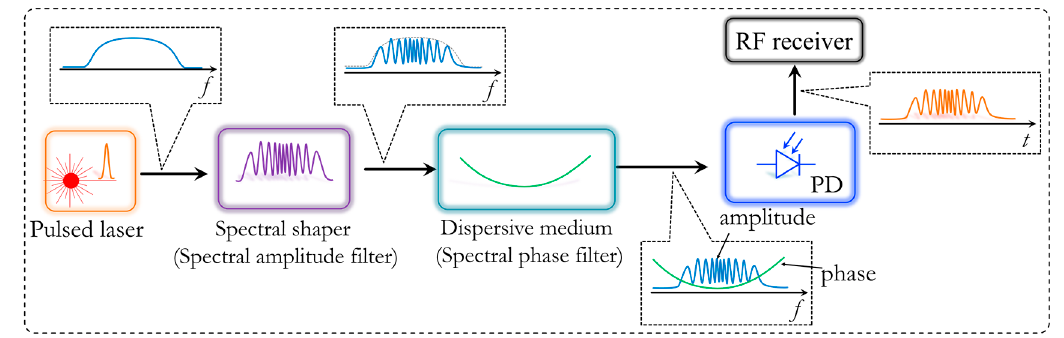
Figure 22. Schematic of an AWG system based on spectral shaping and wavelength-to-time mapping (SS-WTT) mapping technique.